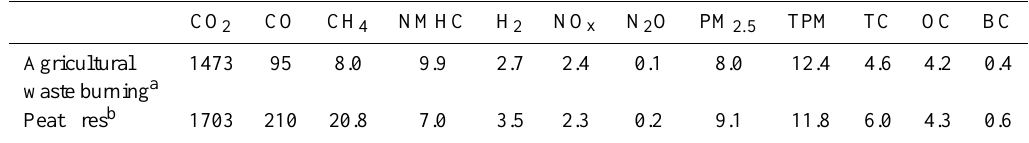
Table 3. Emission factors of trace gases and aerosols (g species (kgdm) − 1 ). CO 2 : carbon dioxide, CO: carbon monoxide, CH 4 : methane, NMHC: non-methane hydrocarbon, H 2 : hydrogen gas, NO x : nitrogen oxides, N 2 O: nitrous oxide, PM 2 . 5 : particles less than 2.5 micrometers in diameter, TPM: total particulate matter, TC: total carbon, OC: organic carbon, BC: black carbon.